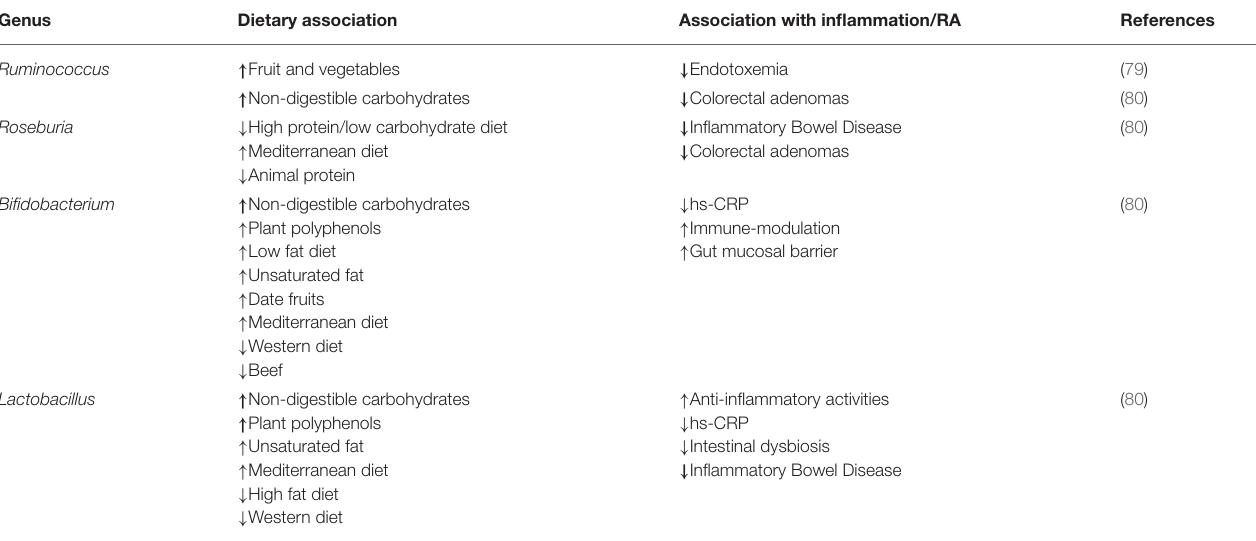
TABLE 1 | Microbiota and inflammatory associations.